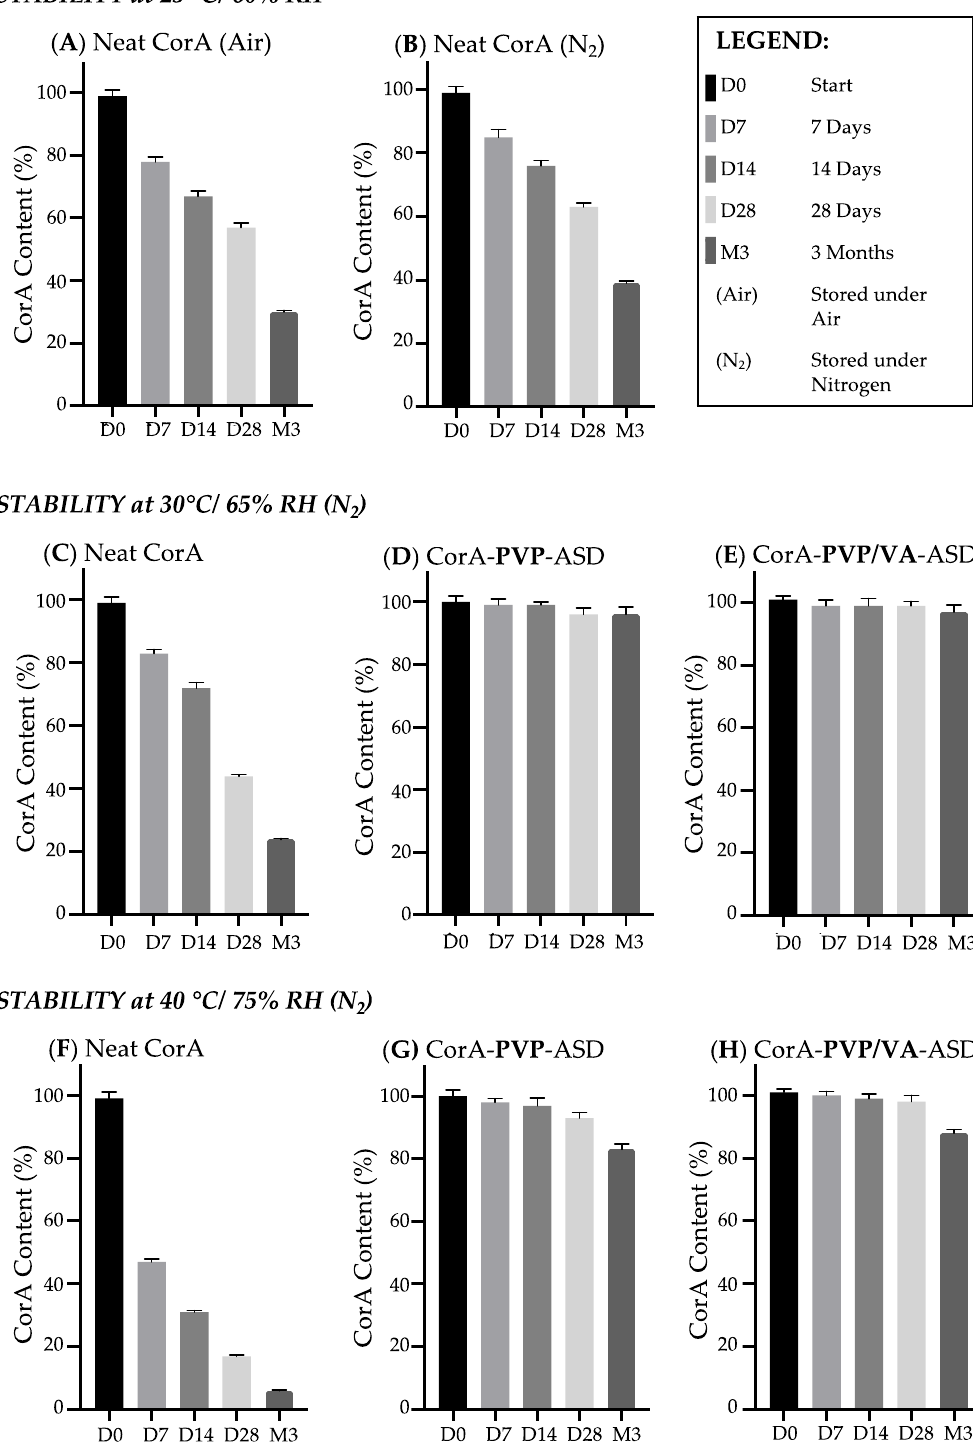
Figure 4. Stability analysis of neat CorA ( A – C , F ), CorA-PVP-ASD ( D , G ), and CorA-PVP/VA-ASD ( E , H ) formulations by HPLC-DAD. Samples were stored in closed twist-o ff glass vials with desiccant at ( E , H ) formulations by HPLC-DAD. Samples were stored in closed twist-off glass vials with desiccant 25 ◦ C / 60% RH ( A , B ), 30 ◦ C / 65% RH ( C – E ) and 40 ◦ C / 75 % RH ( F – H ) ( n = 3, mean, at 25 °C/60% RH ( A , B ), 30 °C/ 65% RH ( C – E ) and 40 °C/75 % RH ( F – H ) ( n = 3, mean, SD).